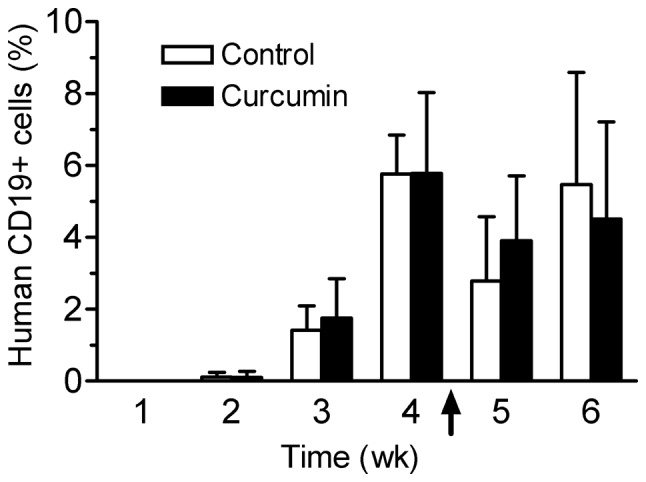
The percentage of human CD19+ cells in the mouse peripheral blood leukocyte (PBL) population was similar over time between the mice receiving control or curcumin diets. Mice (n=16 per group) were fed the control diet or a diet containing 0.5% w/w curcumin beginning at the age of 5 weeks. The mice were injected with SEM cells through the tail vein at 8 weeks of age. Two weeks after injection of leukemia cells, the PBLs were isolated from each mouse weekly and stained with PE-Cy7-conjugated anti-human CD19 and APC-Cy7-conjugated anti-mouse CD45 antibodies to monitor engraftment and growth by flow cytometry. Engraftment was monitored weekly. Three of the mice in the dietary curcumin group were not engrafted and were eliminated from the analysis. The arrow indicates the beginning of vincristine treatment. No difference in the percentage of CD19+ cells was observed between the 2 dietary groups. Data represent the means ± SD. The data for the control group was used previously in a parallel analysis of dietary resveratrol treatments (24).